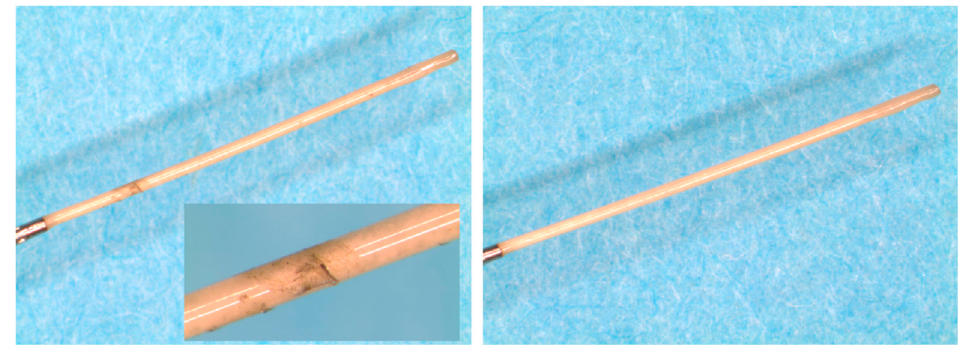
Figure 5. PDMS/DVB/PDMS fiber lifetime evaluation in spinach: stereomicroscope images of the fiber before ( left ) and after ( right ) manual cleaning of the coating [163] .